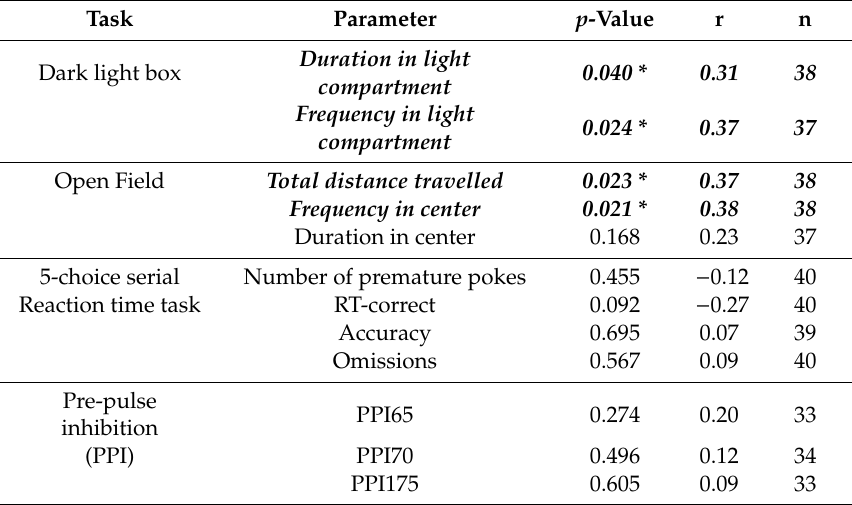
Table 1. Myelin gene expression of BXD lines correlates with behavioral phenotypes. Task Parameter p -Value r n Duration in light 0.040 * 0.31 38 Dark light box compartment Frequency in light 0.024 * 0.37 37 compartment Open Field Total distance travelled 0.023 * 0.37 38 Frequency in center 0.021 * 0.38 38 Duration in center 0.168 0.23 37 5-choice serial Number of premature pokes 0.455 − 0.12 40 Reaction time task RT-correct 0.092 − 0.27 40 Accuracy 0.695 0.07 39 Omissions 0.567 0.09 40 Pre-pulse PPI65 0.274 0.20 33 inhibition (PPI) PPI70 0.496 0.12 PPI175 0.605 0.09